Question: Which visualization type does this figure use?
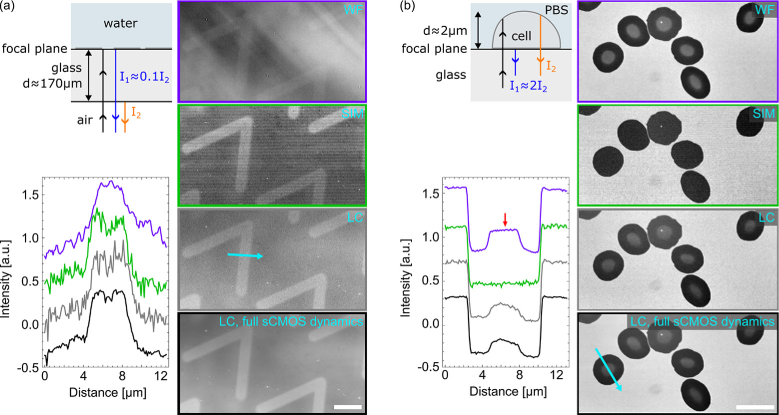
Answer: bar